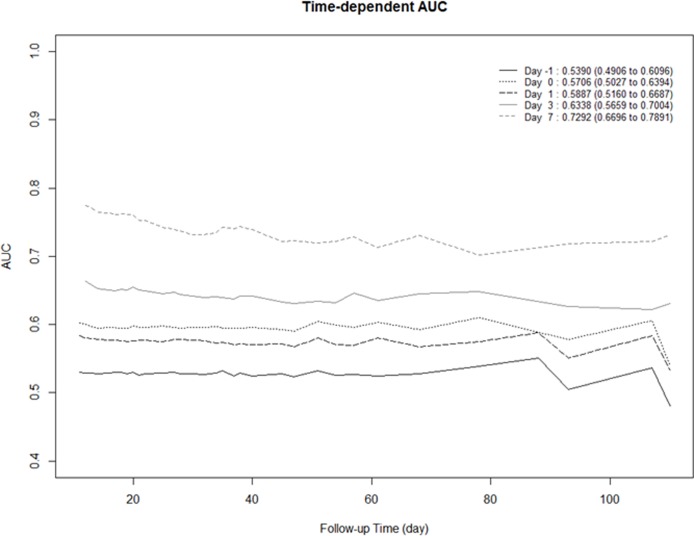
Time-dependent receiver operating curve analysis to evaluate the predictive accuracy of each measurement day.Results in the top right-hand corner of the figure indicate the integrated area under the curve (iAUC) and 95% confidence interval. The iAUC is a measure of the predictive accuracy for in-hospital mortality on each measurement day. The cholesterol level measured on postoperative day 7 had the highest iAUC.